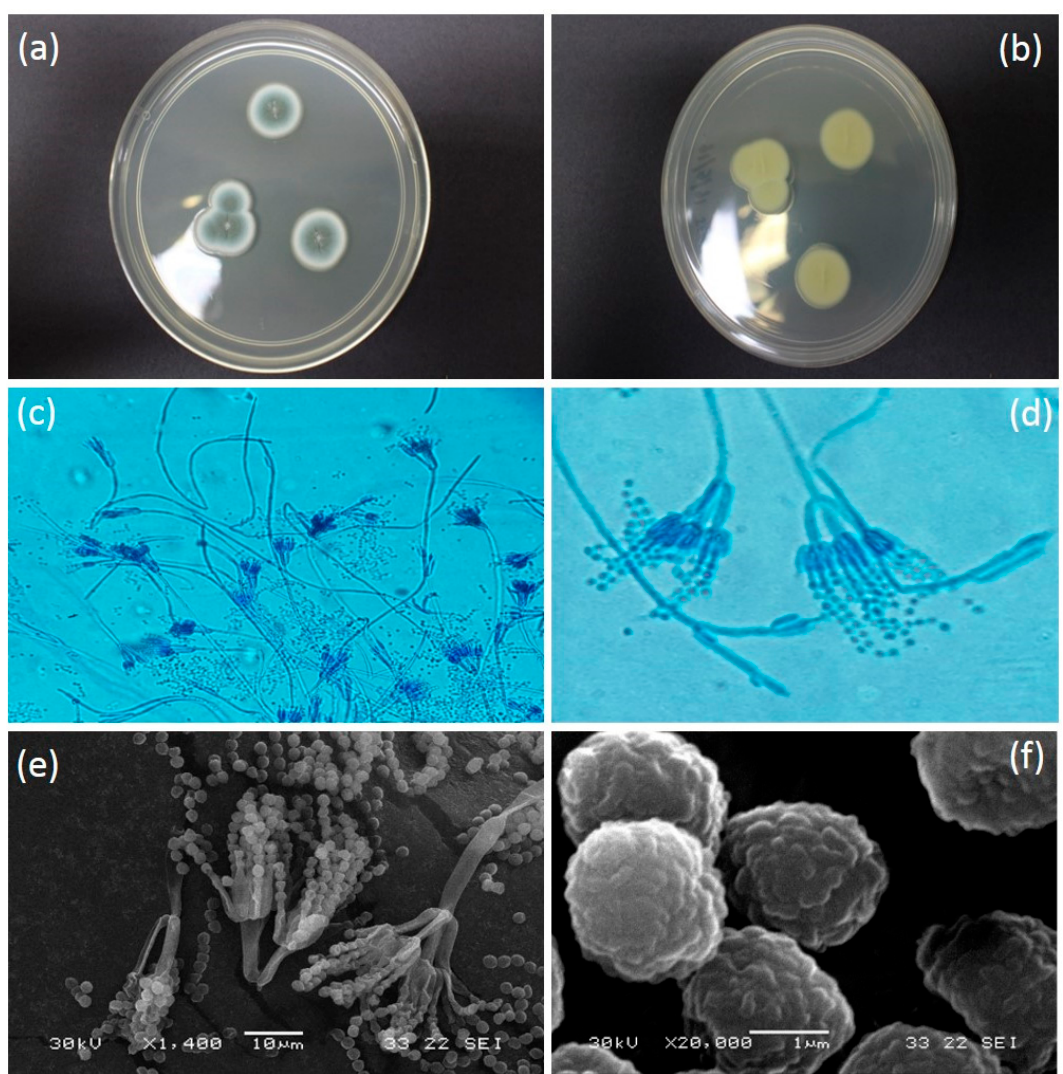
Figure 3. ( a ) Colony surface on PDA media (seven days, 26.8 °C); ( b ) Reverse colony in PDA (seven days, 26.8 °C); ( c ) Hyaline hyphae with smooth-walled conidiophore stripes in 100–300 µm (magnification